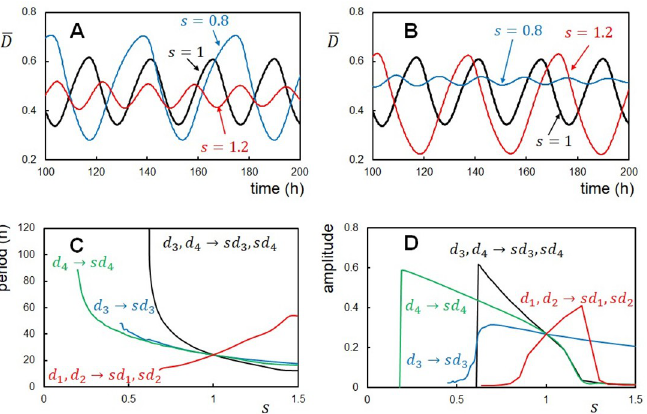
Fig 3. Effects of modification of the reaction-structure feedback strength. ( A ) and ( B ) Example oscillations of the ensemble-averaged phosphorylation level � D ð t Þ with a varying factor s . ( A ) The negative feedback coupling between structure and reactions was modified; the coupling with the P/dP reactions d 3 and the one with the ATPase reactions d 4 were modified to sd 3 and sd 4 with s = 0.8 (blue), 1.0 (black), and 1.2 (red). ( B ) The positive feedback coupling between structure and the binding/unbinding reactions was modified; the coupling with the KaiA binding/unbinding d 1 and the one with the KaiB binding/unbinding d 2 were modified to sd 1 and sd 2 with s = 0.8 (blue), 1.0 (black), and 1.2 (red). Period ( C ) and amplitude ( D ) of the simulated � D ð t Þ oscillations plotted as functions of the scaling factor s for modifying d 3 to sd 3 while d 1 , d 2 , and d 4 being kept constant (blue), d 4 to sd 4 while d 1 , d 2 , and d 3 being kept constant (green), d 3 and d 4 to sd 3 and sd 4 while d 1 and d 2 being kept constant (black), and d 1 and d 2 to sd 1 and sd 2 while d 3 and d 4 being kept constant (red). N = 1000 and temperature was T 0 =